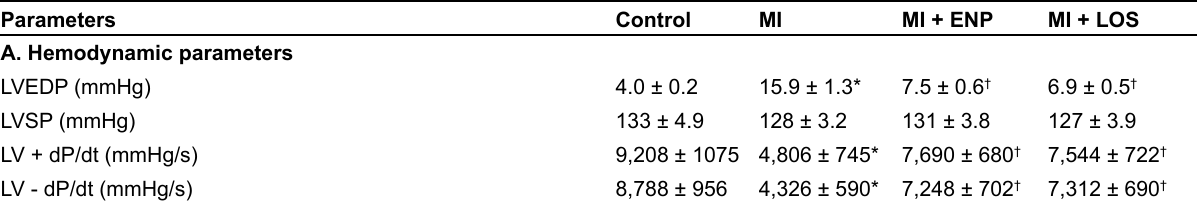
heart failure. Table 1. Cardiac performance, status of RAS and oxidative stress in control and MI animals with or without ENP and LOS treatments for 4 weeks starting at 3 weeks after induction of MI Parameters Control A. Hemodynamic